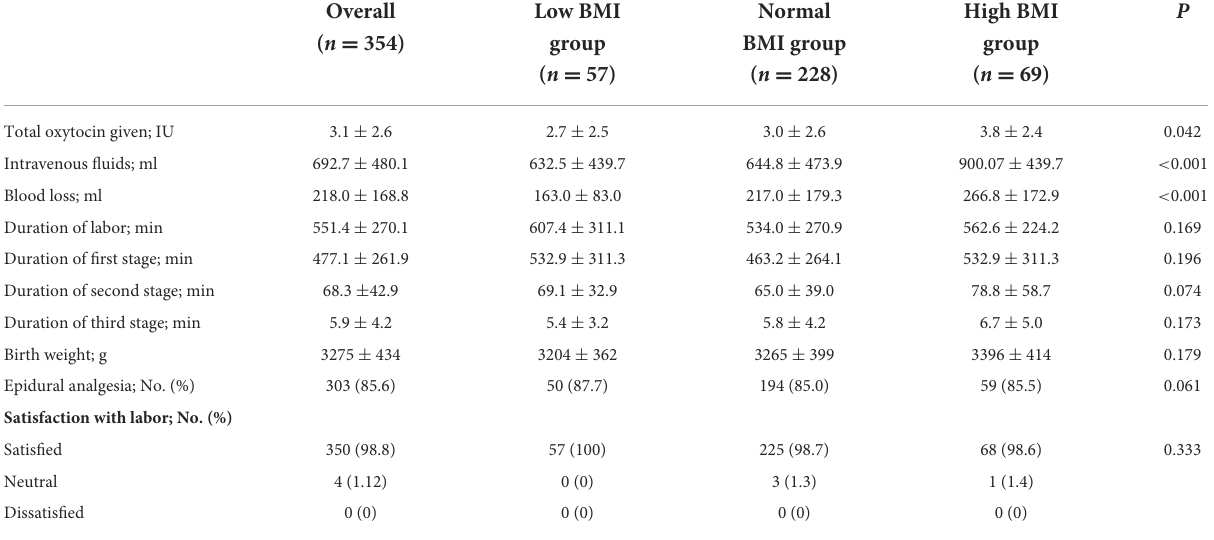
TABLE 2 Obstetrics data and labor management details in three